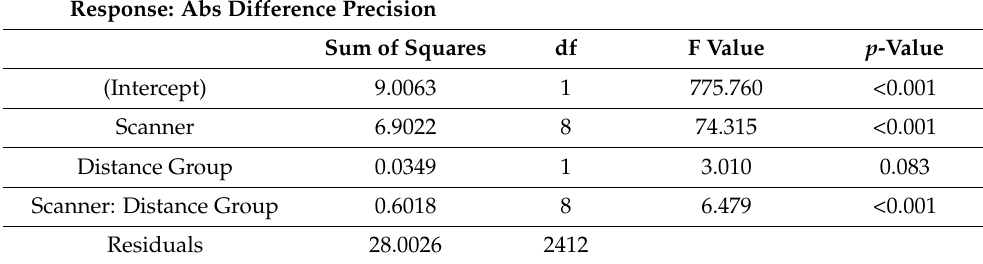
Table 3. ANOVA results for